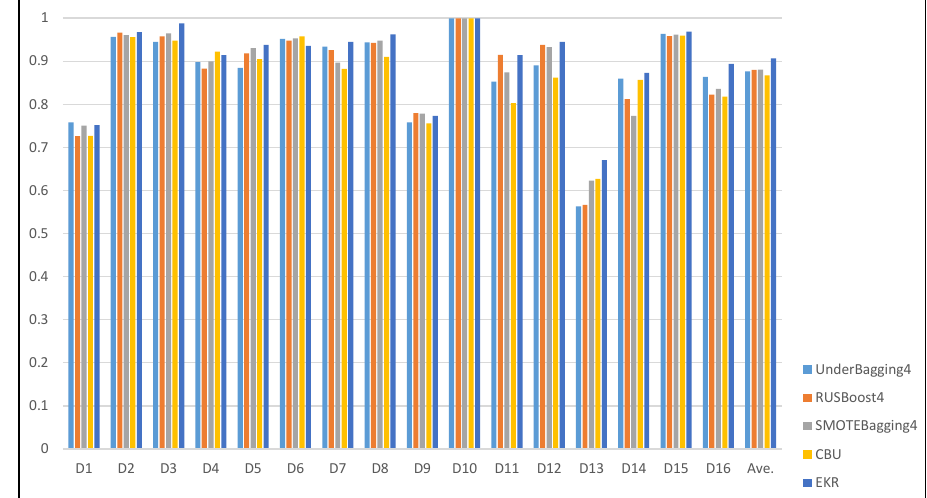
Figure 7. Area under curve (AUC) comparisons of four baseline models and EKR.